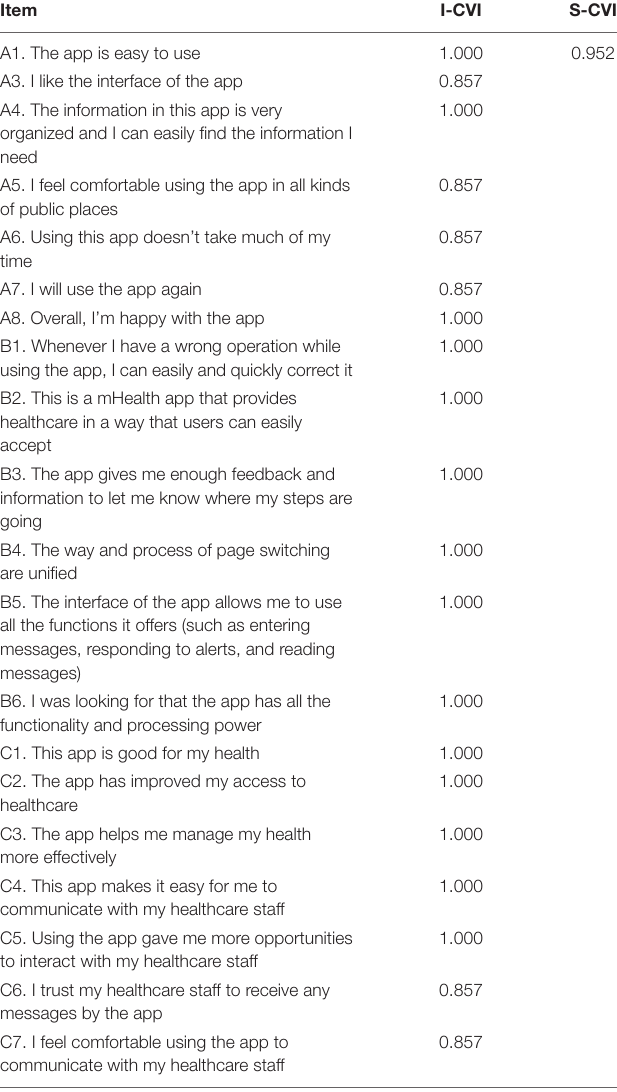
TABLE 3 | The Pearson’s correlation coefficient between each item and the total score of the questionnaire.